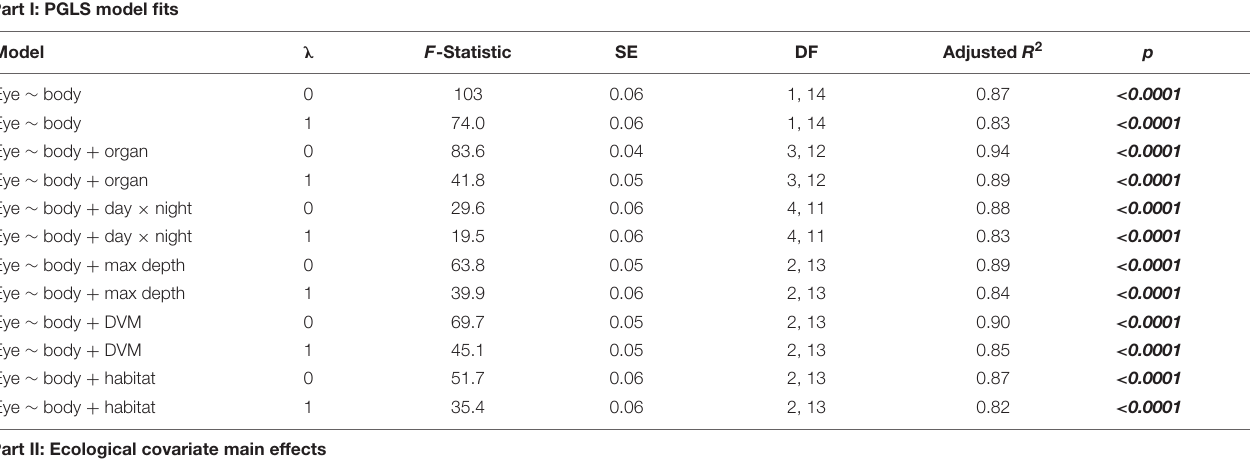
TABLE 3 | Summary of phylogenetic generalized least squares (PGLS) models of relative eye size in sergestid